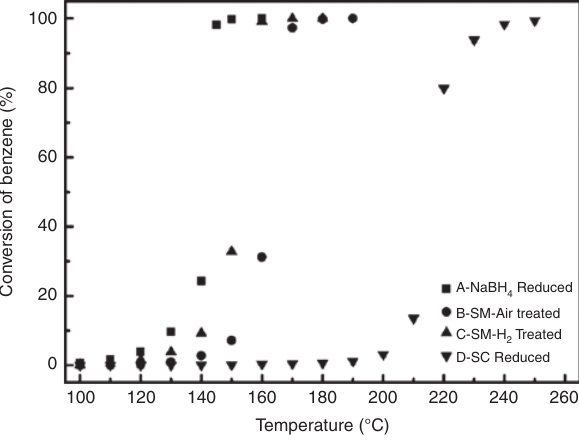
Figure 6: Benzene conversion (%) as a function of temperature ( ° C) over the Pt/SBA-15 catalysts prepared by different methods. (A) Reduced by NaBH without calcination, (B) impregnated and 4 treated at 450 ° C in air, (C) impregnated and treated at 450 ° C in H and (D) reduced by sodium citrate without calcination. 2 Benzene concentration = 1000 ppm in air, catalyst weight = 100 mg (mesh = 40–60) and SV = 60,000 mL g -1 h -1 . Reproduced from [45] with permission from Springer.